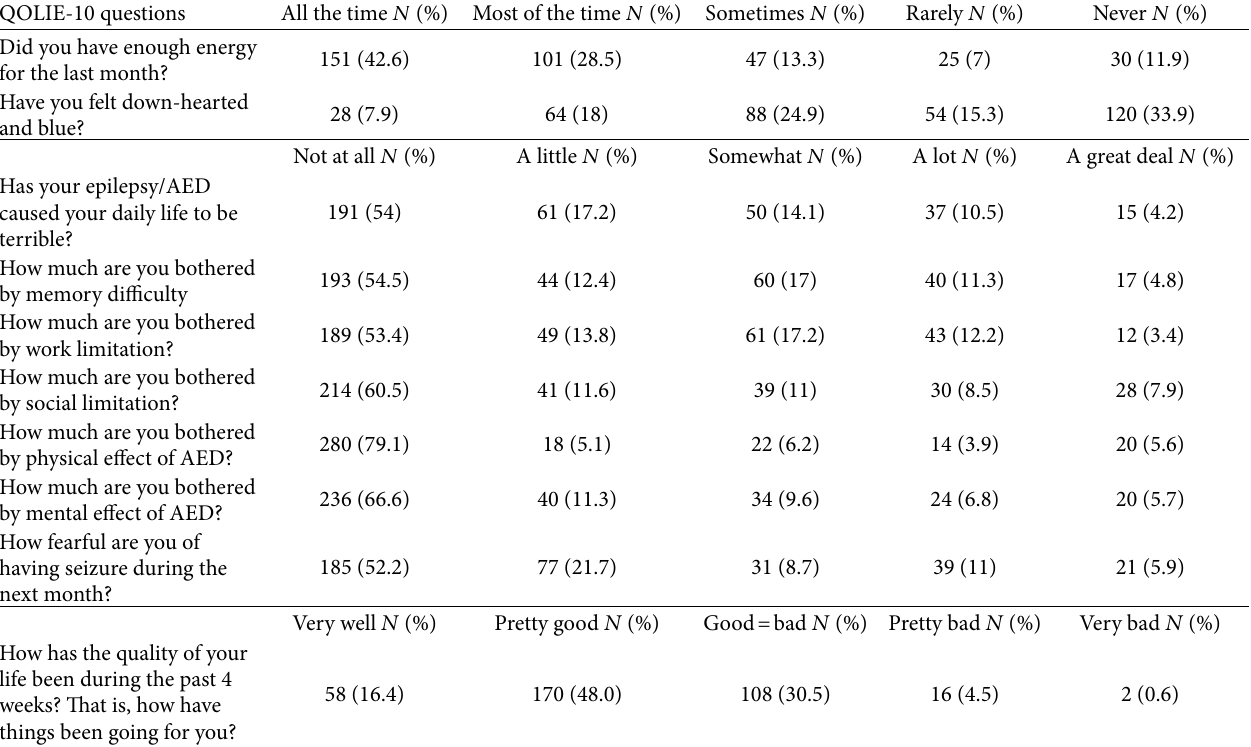
Table 3: Response of patients for quality of life assessment questions, UoGRH, Northwest Ethiopia;